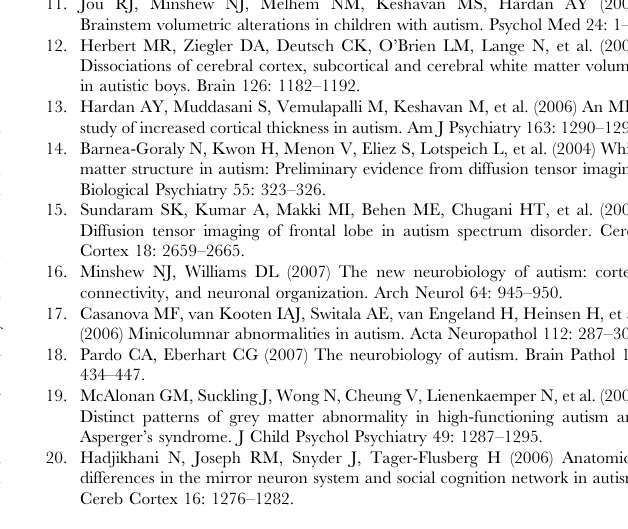
Mean (SD) Mean (SD) t-value DF p-value 2